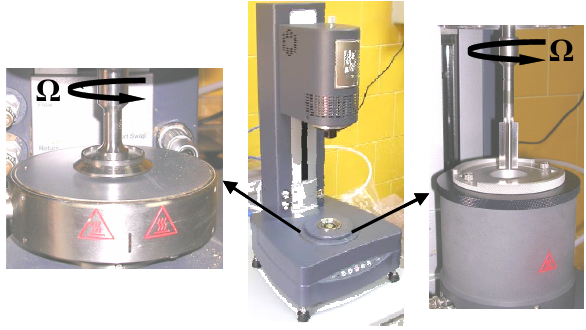
Fig. 2. The rotational rheometer AR 2000ex (TA Instruments) and the two rheometrical system used: parallel plates and vane rotor